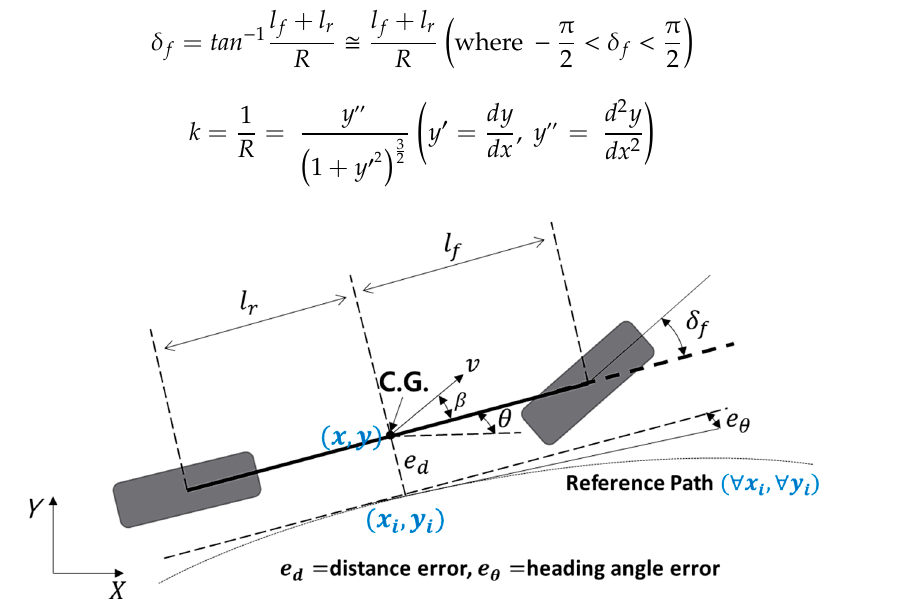
Figure 3. Two degree-of-freedom (DOF) bicycle kinematic model and lateral control parameters.